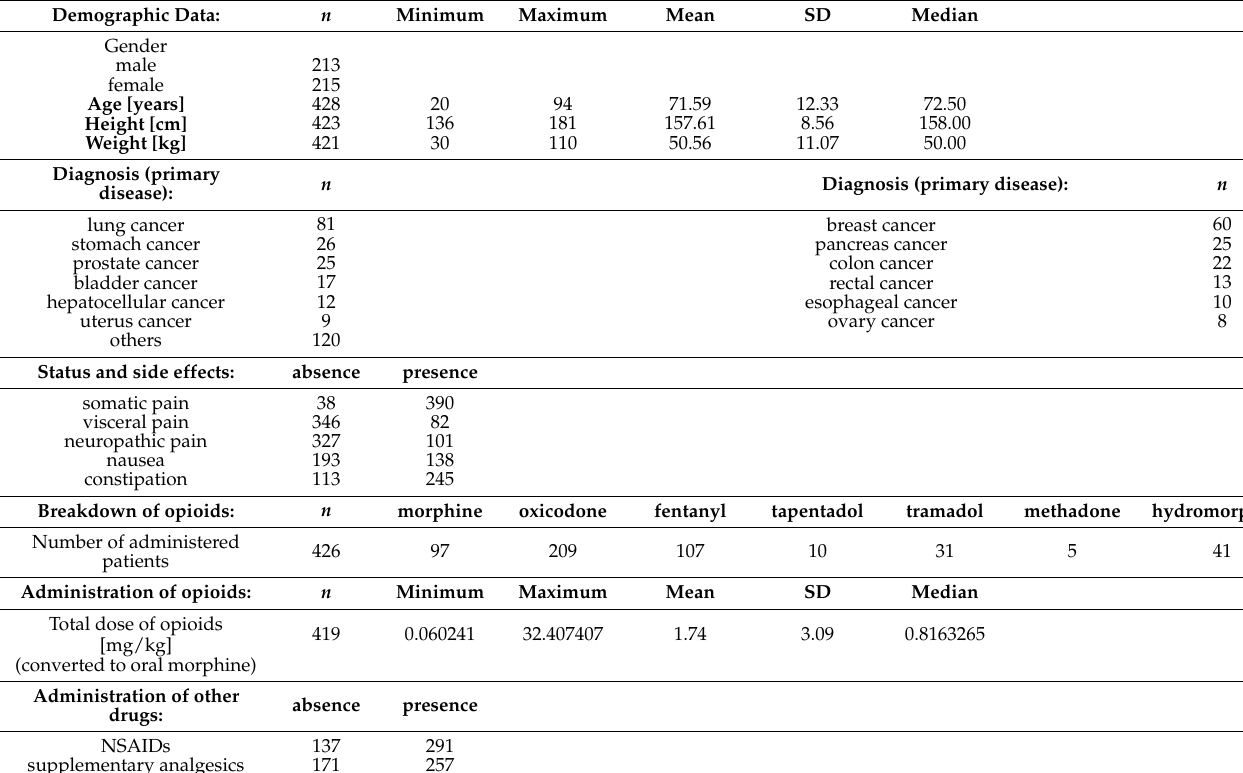
Table 1. Demographic and clinical data of patient